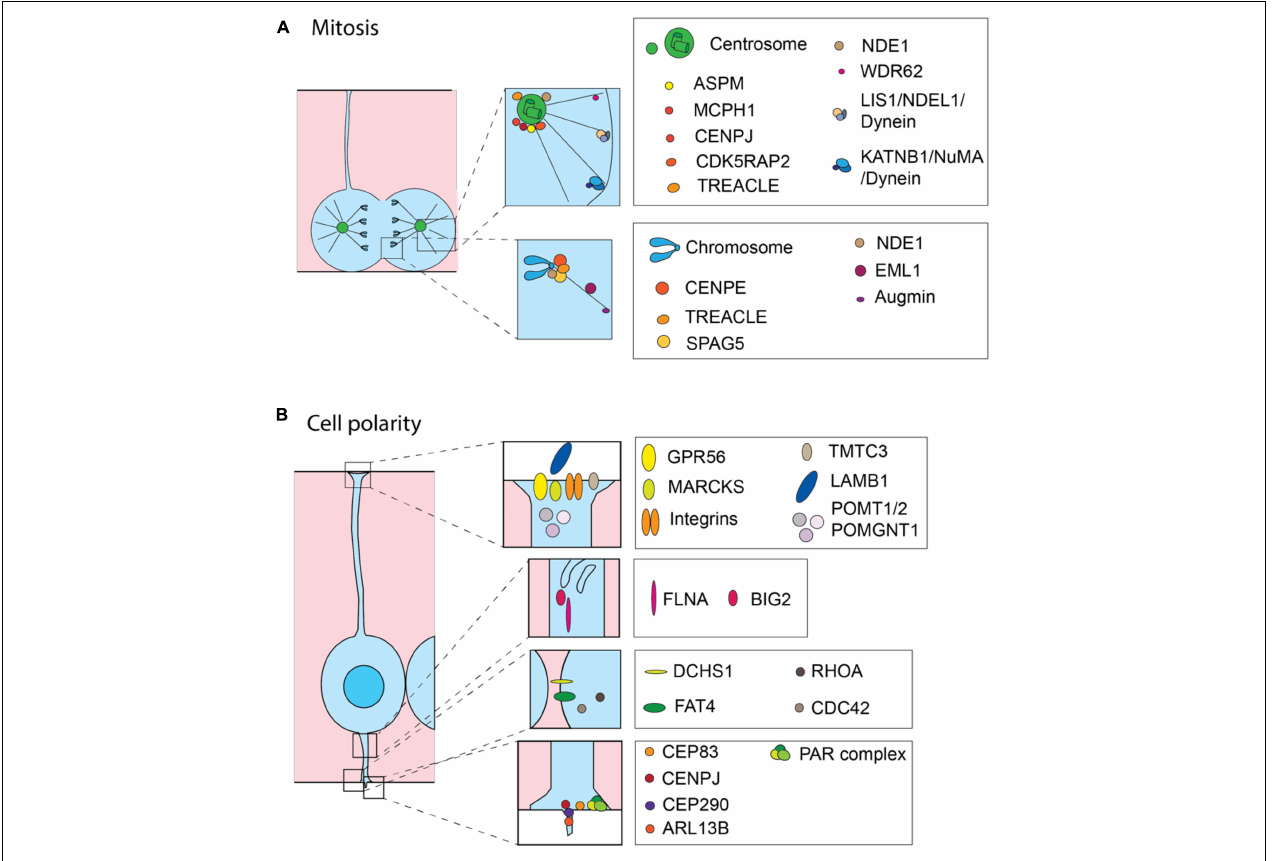
FIGURE 2 | Cell biological processes and molecules involved in the onset of MCDs. Schematic representation of proteins involved in MCDs. Most of the proteins are related to the precise regulation of mitosis (A) and maintaining correct cell polarity (B) . (A) During mitosis the MCD-involved proteins are mainly operating at the centrosome and astral microtubules (upper inset) or at the kinetochore (lower inset). (B) In interphase, MCD-involved proteins are operating at the basal endfoot (first inset from the top), intracellular trafficking (second inset from the top), adherens junctions (third inset from the top) and apical endfoot including cilium (the lowest inset) to maintain cell